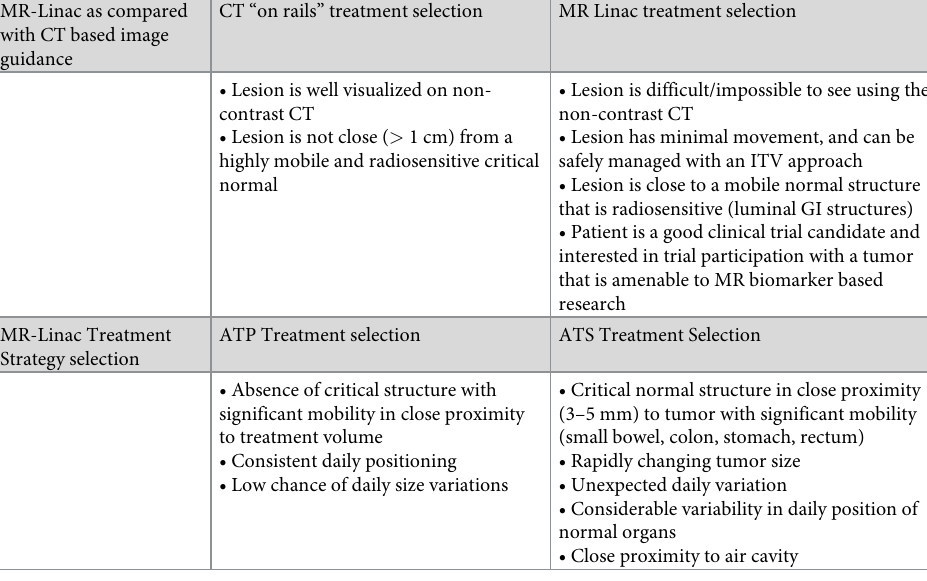
Table 2. Selection considerations for MR-Linac treatment and ATP versus